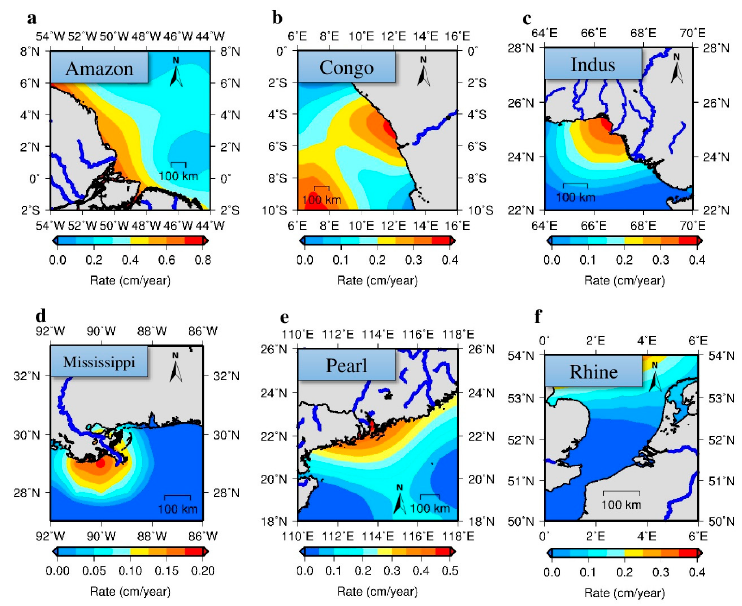
Figure 10. GRACE-derived EWH rates near the estuaries of the ( a ) Amazon; ( b ) Congo; ( c ) Indus; ( d ) Mississippi; ( e ) Pearl and ( f ) Rhine rivers over April 2002–March 2015.